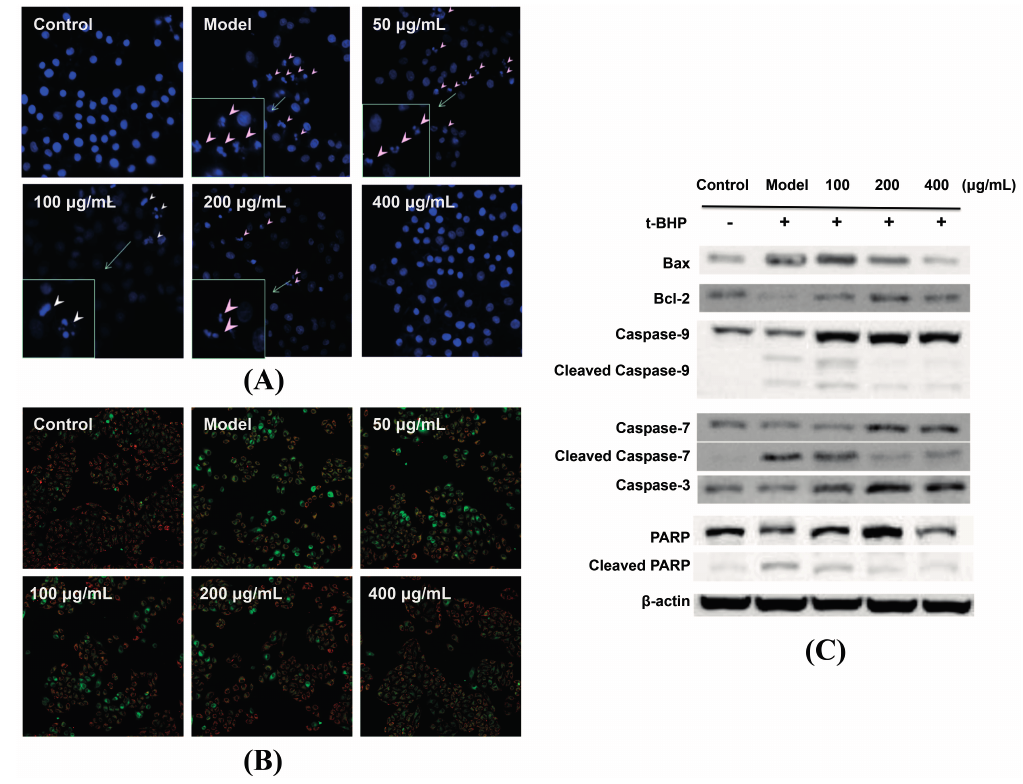
Figure 5. P. chinense extract attenuated t -BHP-induced apoptosis by inhibiting mitochondrial apoptotic pathway in L02 cells. ( A ) L02 cells were pretreated with different concentrations of P. chinense extract for 12 h, followed by exposition to t -BHP for 30 min, and then incubated with JC-1 dye for another 30 min. The cell MMP was measured using In Cell Analyzer 2000. ( B ) L02 cells were treated as described above and cell nuclei were stained with Hoechst 33342 and imaged using an In Cell Analyzer 2000. ( C ) L02 cells were treated as described above and were harvested for western blotting analysis using indicated antibodies. Similar results were obtained from two or three independent experiments. Magnification